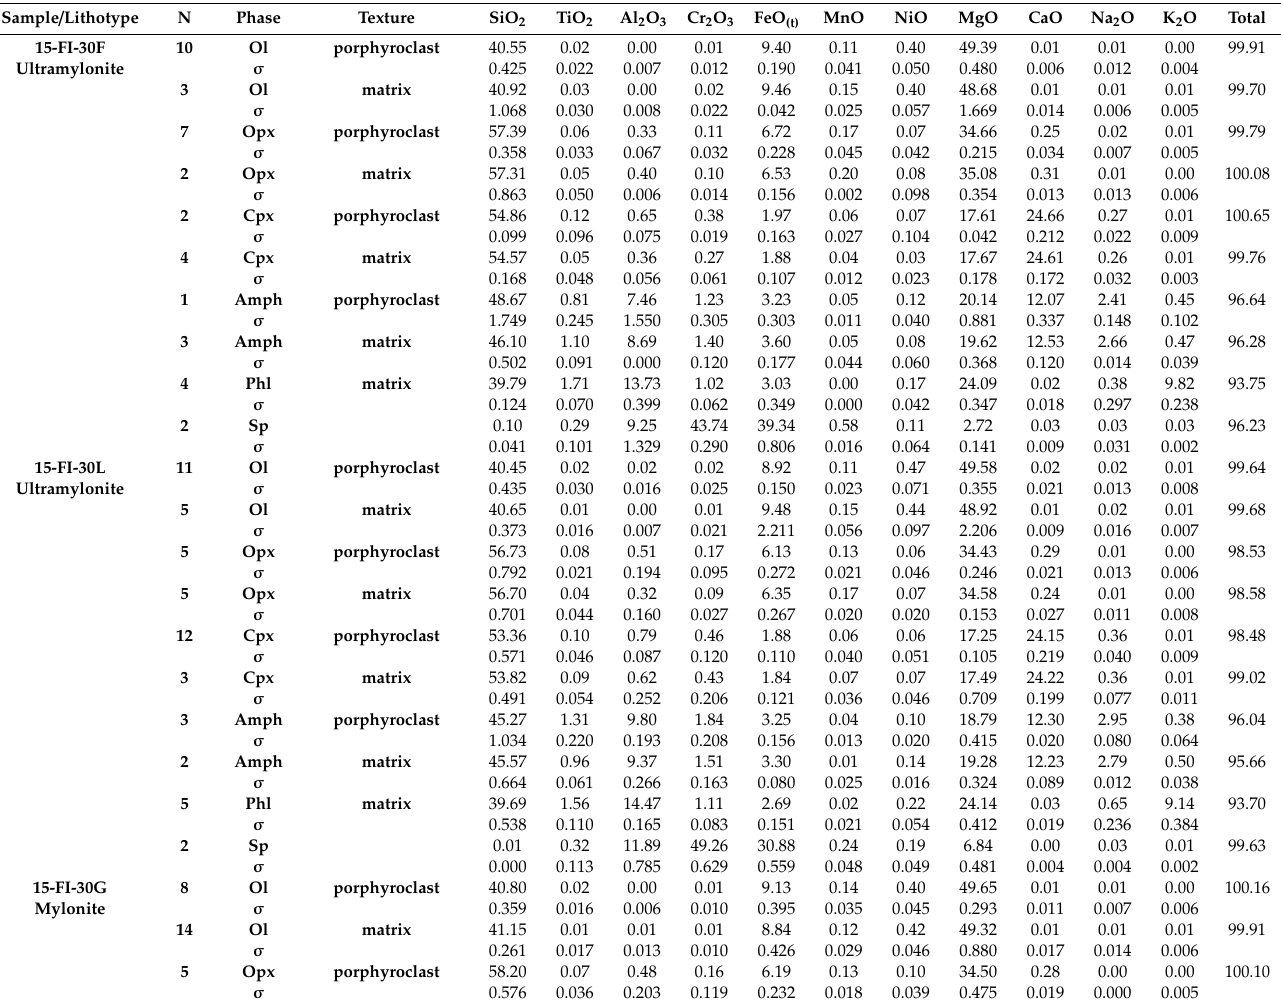
Table 2. Average analyses for major elements (wt.%) of the mineral phases in the Finero ultramafic samples. (FeOt total iron oxide; σ line indicates the standard deviation; N is the number of